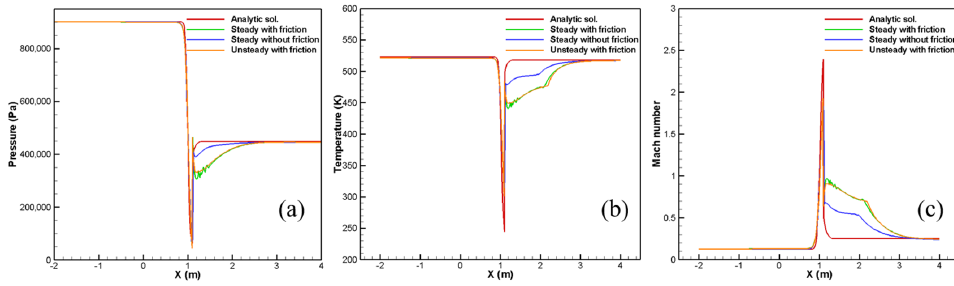
Figure 5. Spatial distributions of ( a ) static pressure; ( b ) temperature; and, ( c ) Mach number along axis of pipe.